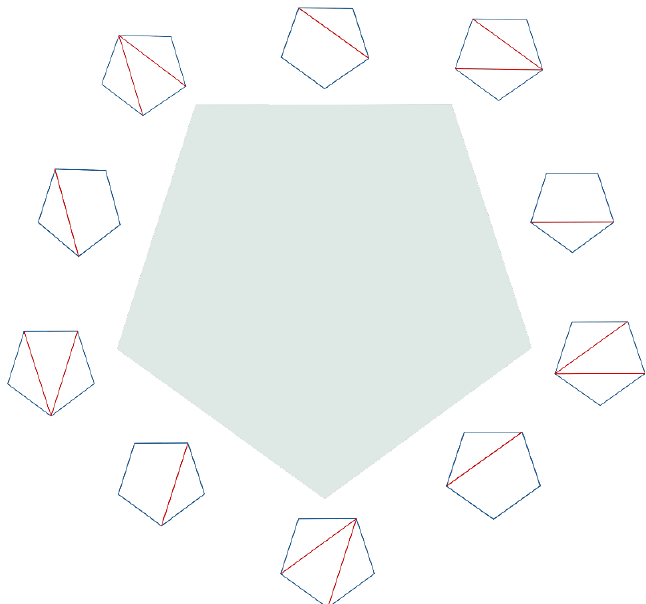
: 5 partial triangulations are represented by 5 diag- A 5